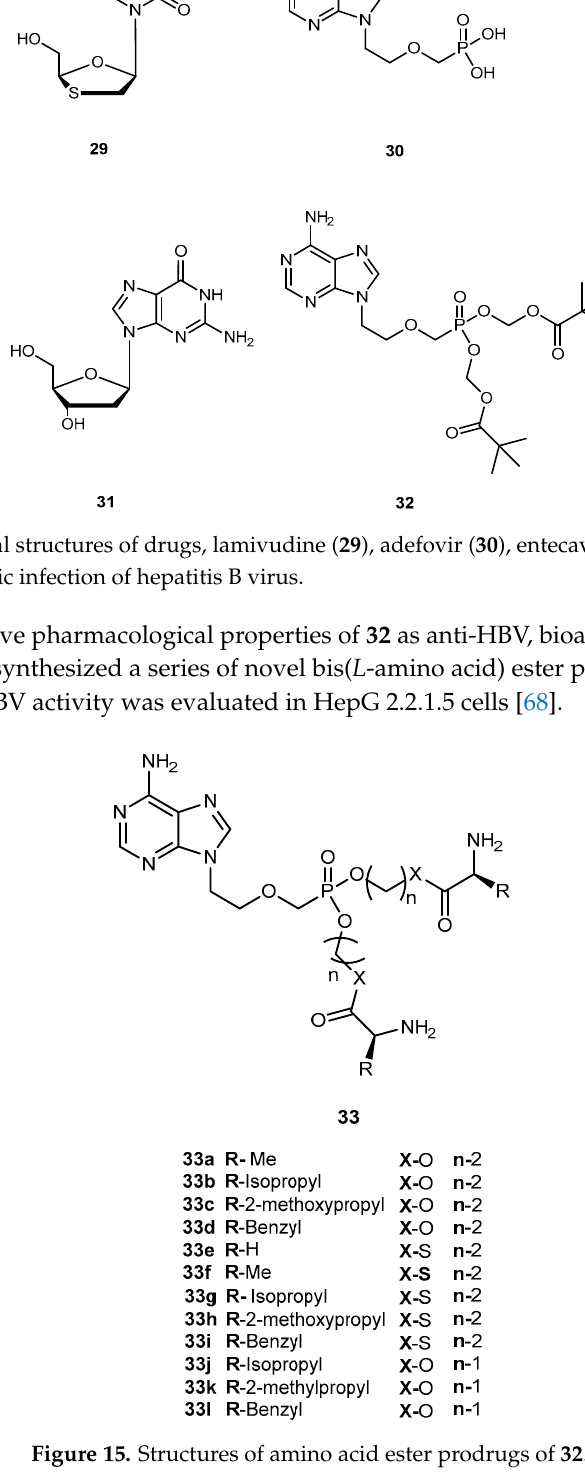
Figure 15. Structures of amino acid ester prodrugs of 32 .